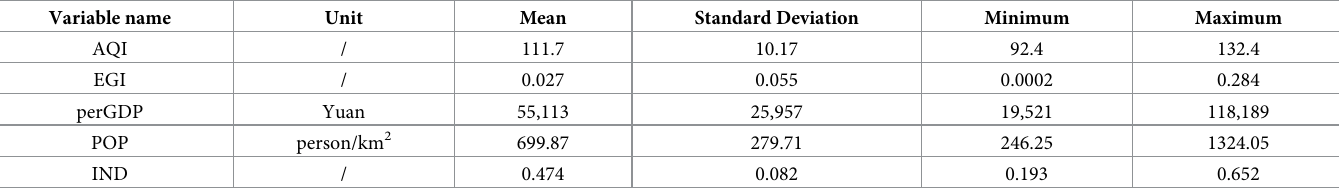
Table 9. The descriptive statistics of variables.